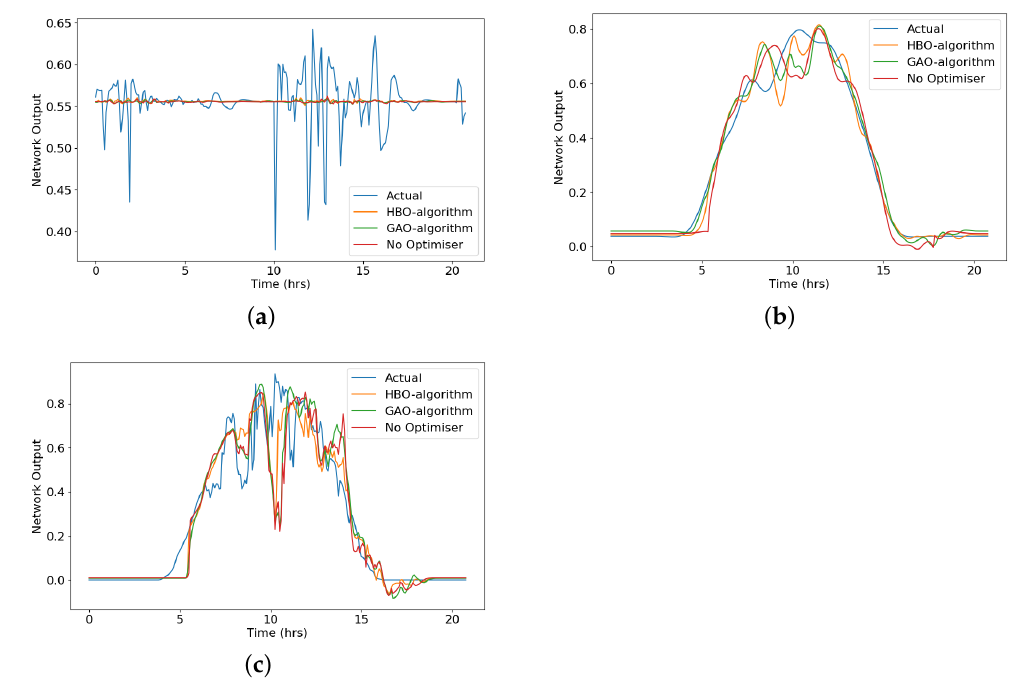
Figure 8. Comparison of HBO-algorithm, GAO-algorithm, No Optimiser LSTM Networks 90 min ahead Forecasts with actual output values: ( a ) Forecast of High Frequency Component of original data ( b ) Forecast of Low Frequency Component of original data ( c ) Forecast of original